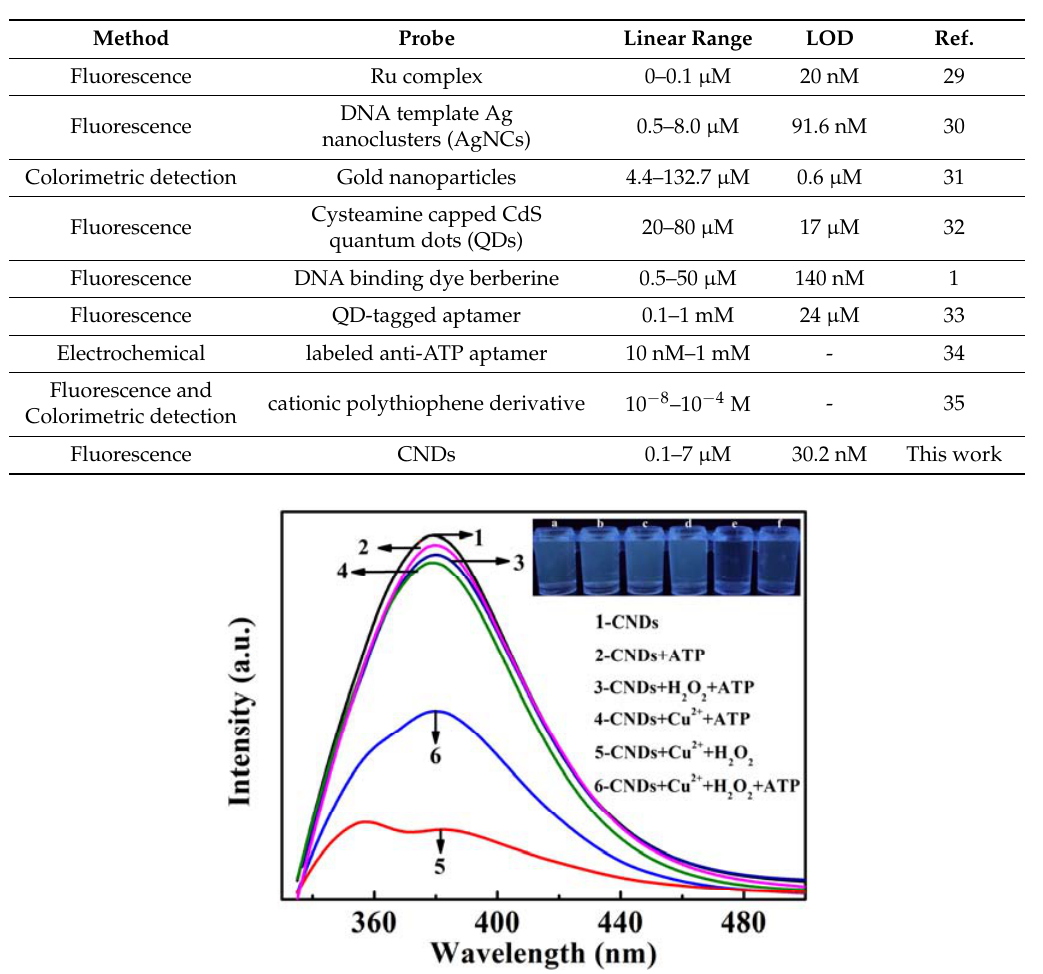
Table 1. Comparison of analysis methods for the detection of ATP.